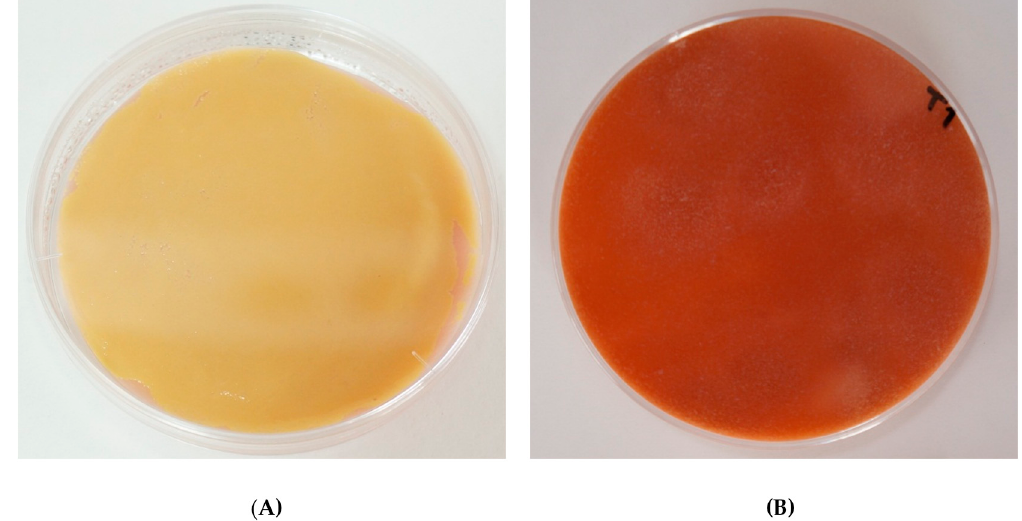
Figure 5. Coloration by Arthrobacter arilaitensis Po102 on CM Dh304 at the initial pH 7.0 without NaCl, as examples for pink coloration observed on the cultures in this study. ( A ) Front view; ( B ) back view.